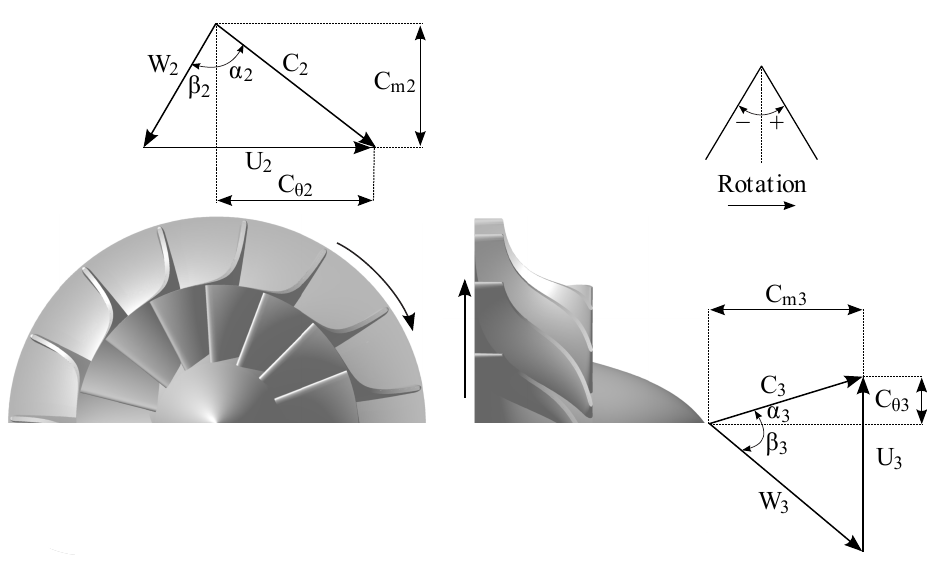
Figure 3. Velocity triangles at both turbine wheel inlet and outlet.